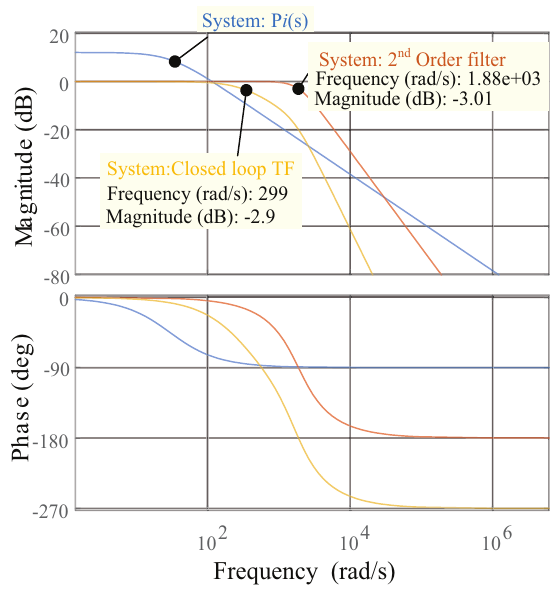
Figure 9. Bode diagram for the inner